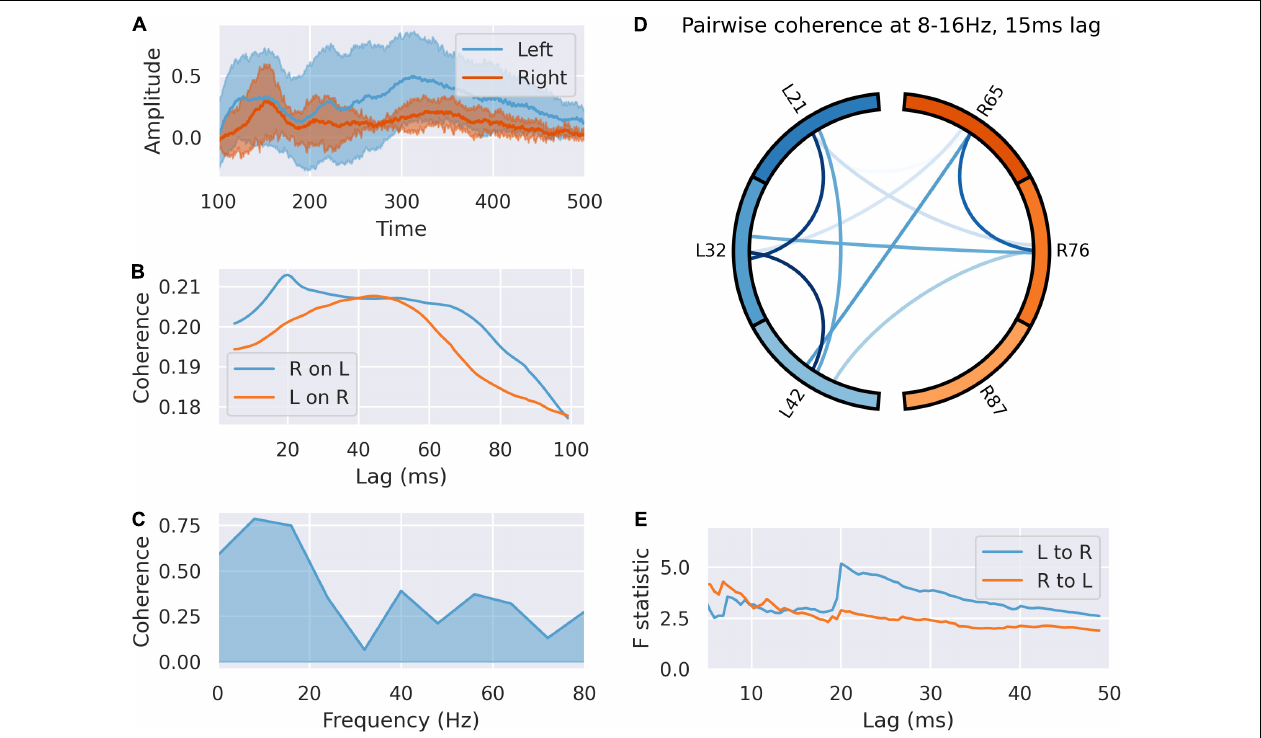
FIGURE 5 | The left signals to the right dACC during the feedback response. (A) Averaged responses of left and right dACC during the 100–500 ms feedback response. The right dACC shows a lagged, blunted response, suggesting it is responding to signals from the left ACC rather than inputs directly. (B) Coherence between left and right dACC signals over a range of time lags. Peak coherence occurs between left dACC and right 15 ms later, suggesting communication from left to right. (C) Coherence spectrum at 15 ms lag. Most of the coherence is accounted for by the sub-16 Hz band. (D) Pairwise coherence for all electrodes at 8–16 Hz with a 15 ms lag. There is widespread coherence during this interval, suggesting coordinated activity. (E) Granger causality of signals in this interval. There is a jump in the test statistic at 20 ms, suggesting left to right communication in this